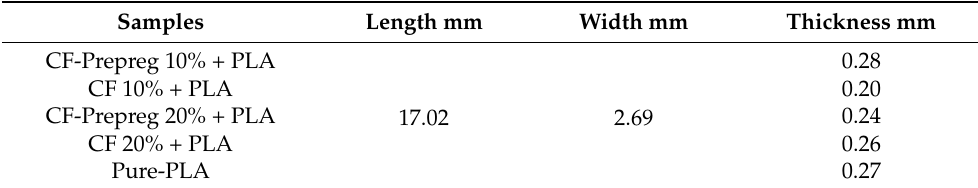
Figure 10. ( a ) Blanking machine, ( b ) Dumbbell shape samples after blanking.